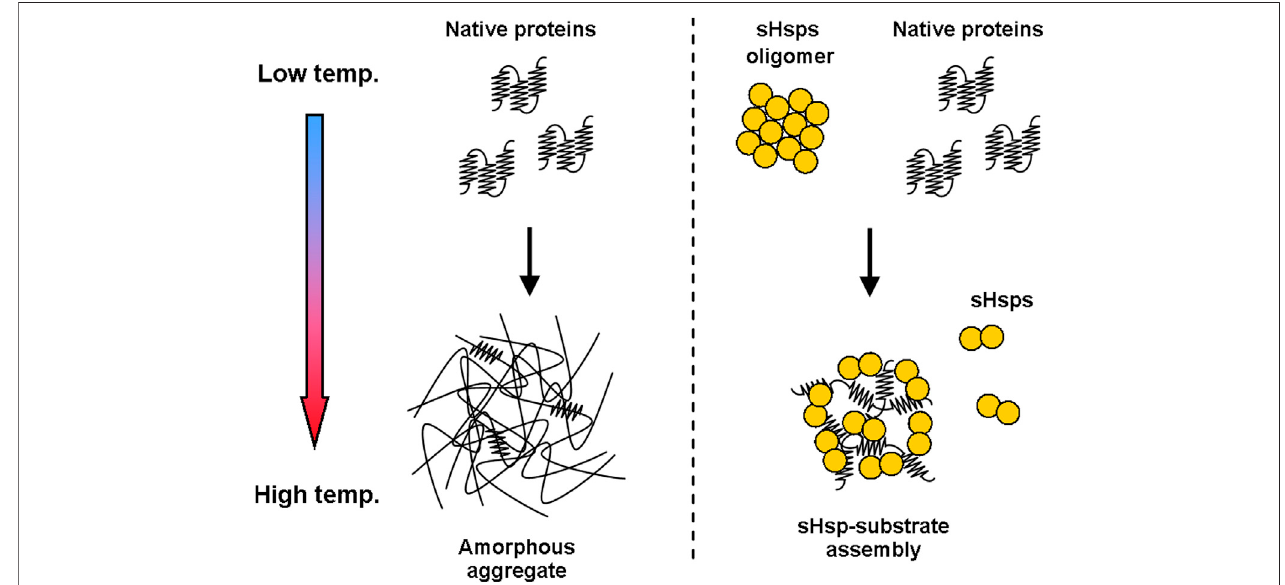
FIGURE 1 | sHsps in fl uence the substrate aggregation process. Temperature increase causes deoligomerization and activation of sHsps, which start binding to partially unfolded polypeptide substrates. This modi fi es the aggregation process and leads to the formation of sHsp-substrate assemblies.